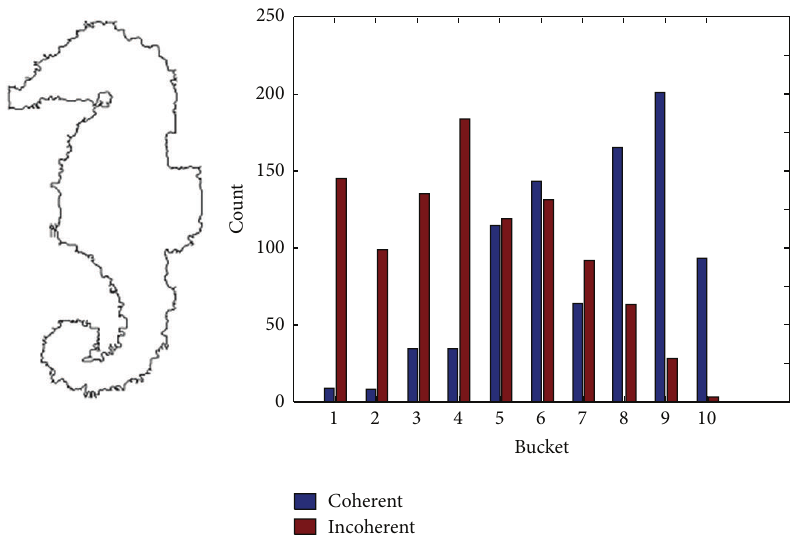
Figure 3: Hippocampus image polluted by noise and its corresponding DCV